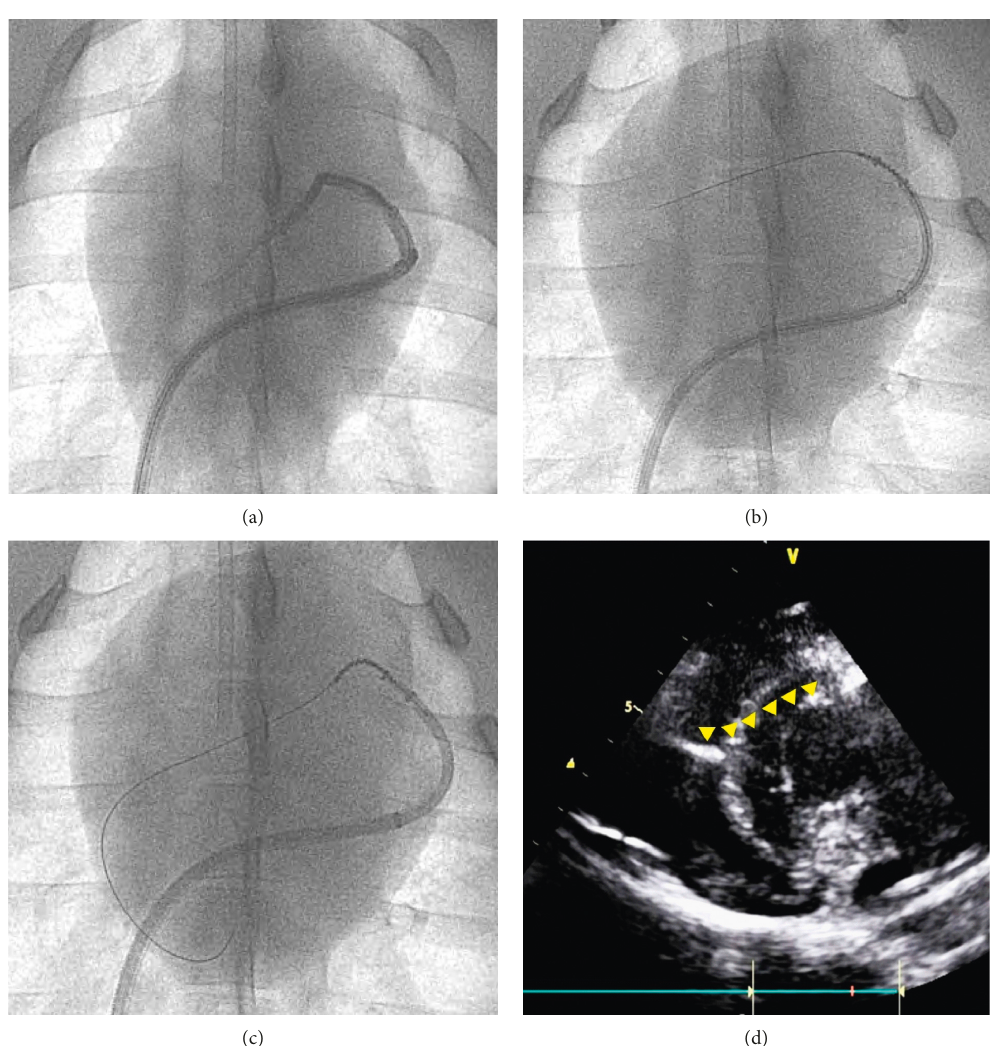
Figure 4: Procedural steps and wire positioning results. (a) Fluoroscopy confirms the anatomy without the septal vein. (b) The guidewire engages the Cobra catheter. (c) The Cobra catheter distal tip angulation towards the direction of the guidewire. (d) The guidewire in the